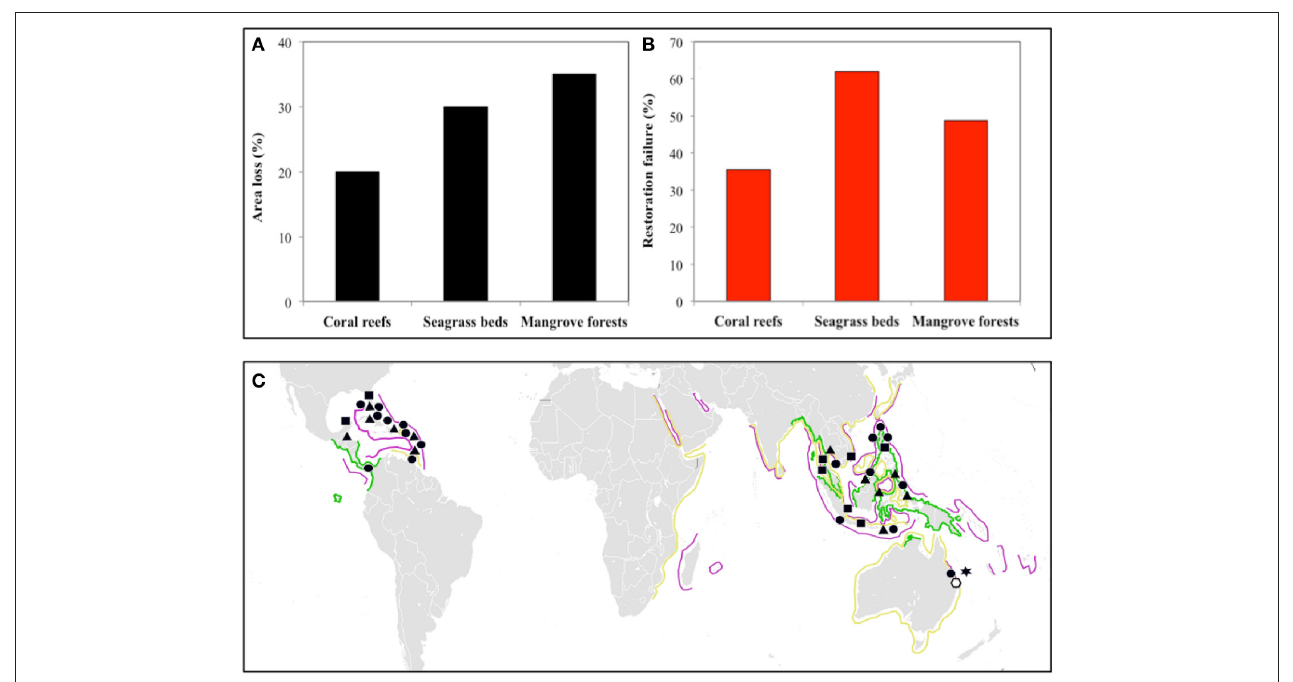
FIGURE 1 | Global area loss, restoration, and management efforts for the three dominant kinds of tropical coastal ecosystems: coral reefs, seagrass beds, and mangrove forests. (A) Percentage loss in area over the last 20–40 years. Data sources: Mangrove forests (Valiela et al., 2001); seagrass beds (Waycott et al., 2009); coral reefs ( Bellwood et al., 2004). (B) Percent restoration failure calculated from the number of restoration projects (106 mangrove forests; 141 seagrass beds; 293 coral reefs) and the number judged unsuccessful ( Bayraktarov et al., 2016). (C) Global distribution of regions with these ecosystem types considered most threatened for mangrove forests (Polidoro et al., 2010; green lines), seagrass beds (Short et al., 2011; yellow lines), and coral reefs (Burke et al., 2011) (purple lines). Management strategies: Triangles, Marine protected areas; Circles, integrated coastal zone management; Squares, restoration efforts; Star and clear Polygon, Land management and water monitoring; respectively ( Gladstone, 2009; Bayraktarov et al.,